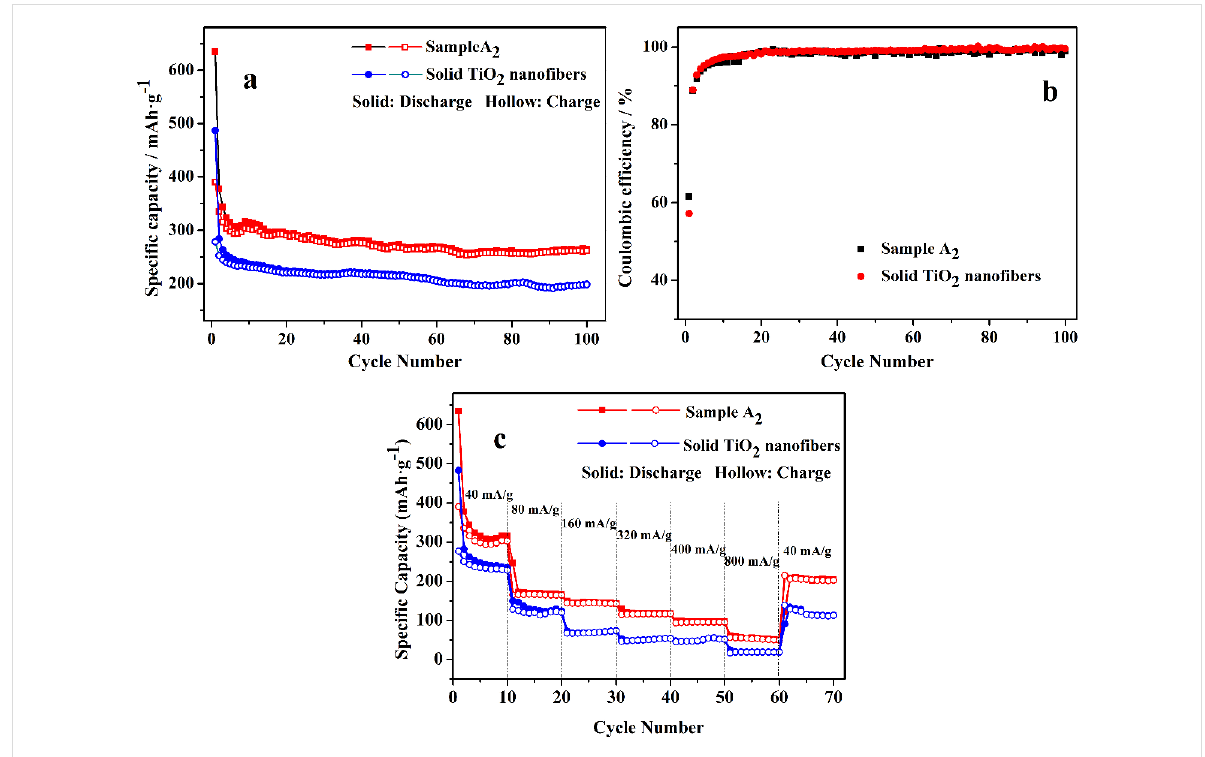
Figure 7: Comparison of cycling performance (a), coulombic efficiency (b) and rate capability (c) of sample A 2 and solid TiO 2 nanofibers.